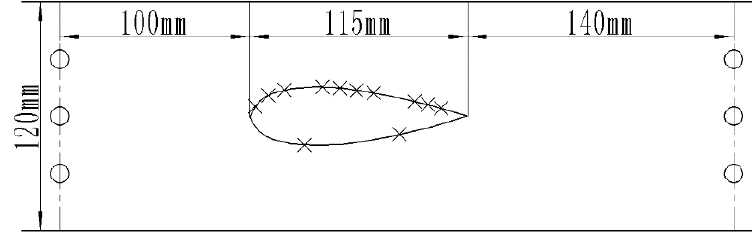
Figure 1. Schematic illustration of the experimental section.